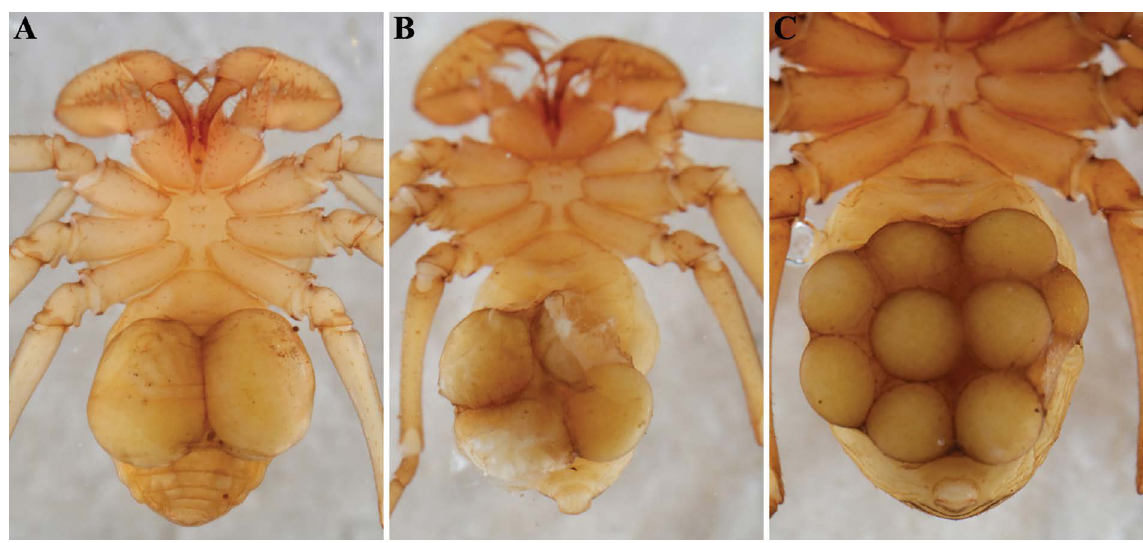
Fig. 143. Sarax ioanniticus (Weygoldt, 2005) comb. nov. (SMNS) , ♀♀, at different developmental stages carrying